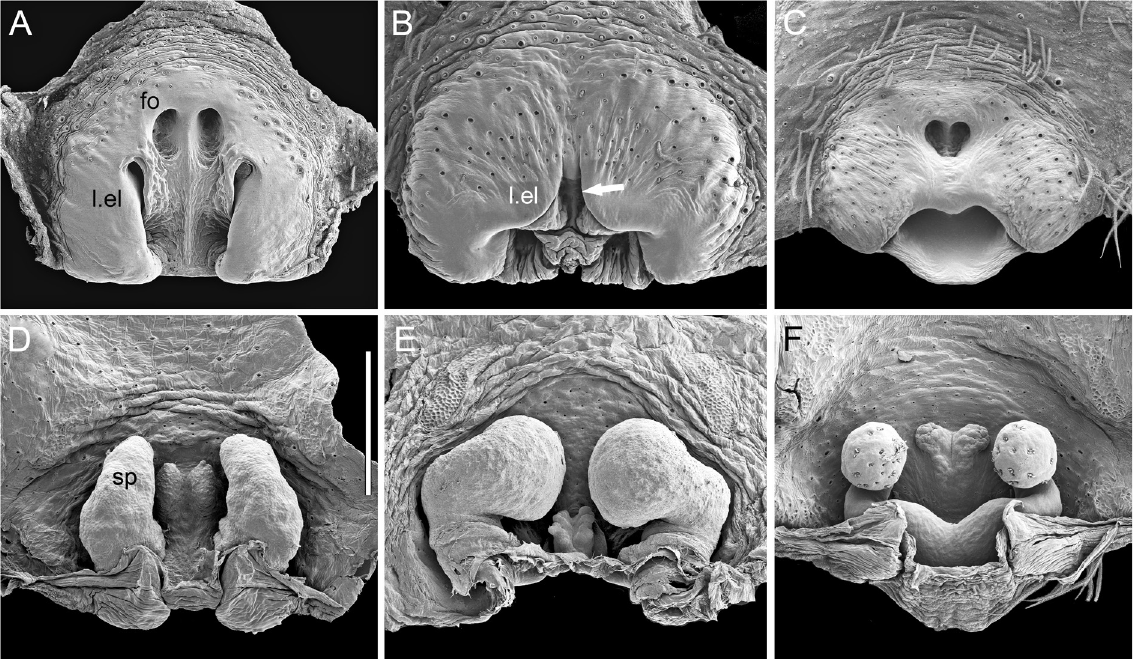
Fig. 8. Epigyne in ventral (A–C) and dorsal (D– F) view. — A , D . Wadicosa benadira (Caporiacco), from Kenya, Marsabit. — B , E . W. cognata sp. nov., from Kenya, Lake Magadi. — C , F . W. jocquei sp. nov. C . From Mauritius. F . From Comoros, Anjouan. fo , foveola; l.el . lateral elevation; sp , sperma- theca; arrow points at lateral elevation partly covering foveola. Scale bars: A–F = 300